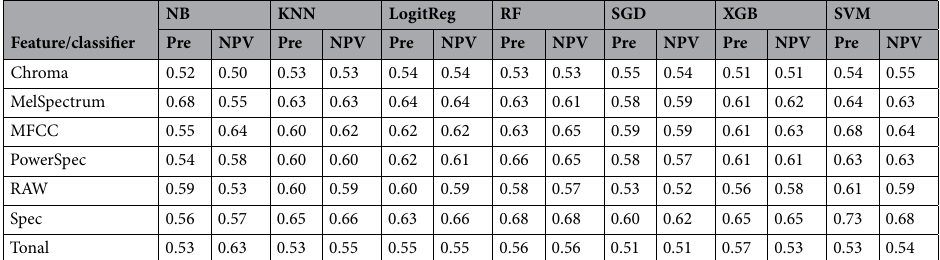
Table 3. Classification precision (Pre) and negative predictive value (NPV) of several shallow machine learning models (training phase).